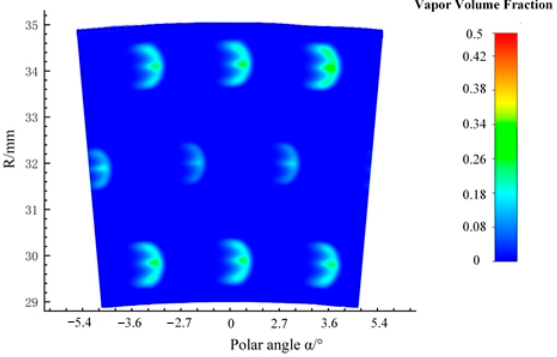
Figure 8. The contour of vapor volume fraction on the upper surface of the water film. Figure 9 is the circumferential velocity streamline diagram of a single circular pit.